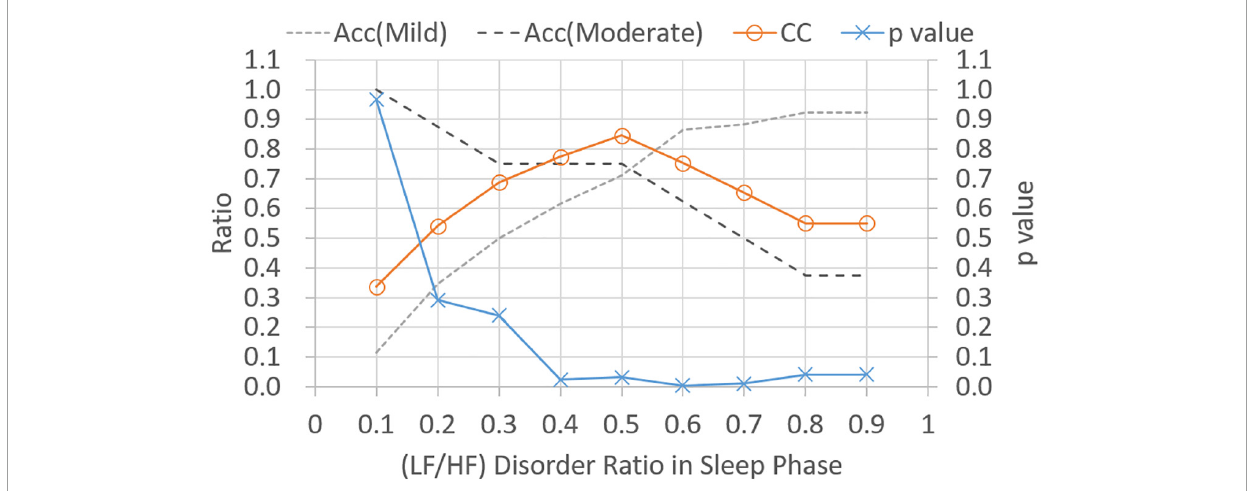
FIGURE5 Classification ratio and p -value obtained from t -test between mild and moderate categories for varied (LF/HF) disorder ratio in sleep phase. “Acc” stands for classification accuracy.